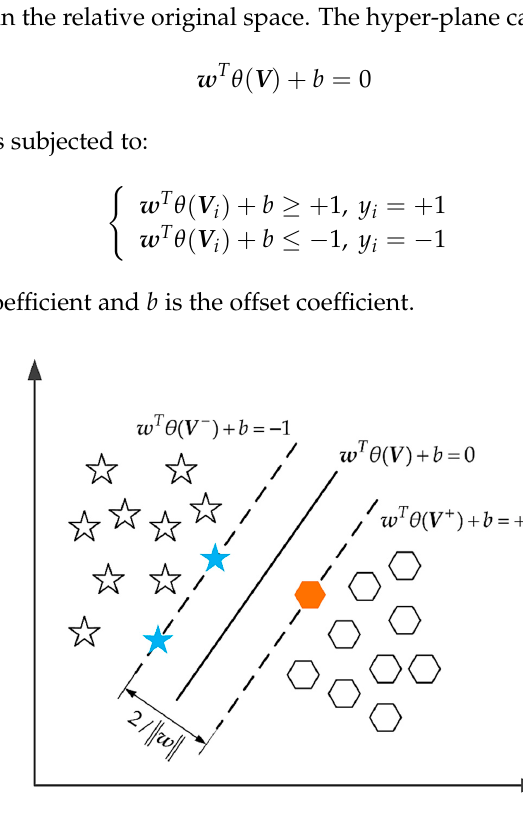
Figure 1. The schematic diagram of support vector machine (SVM) classification.